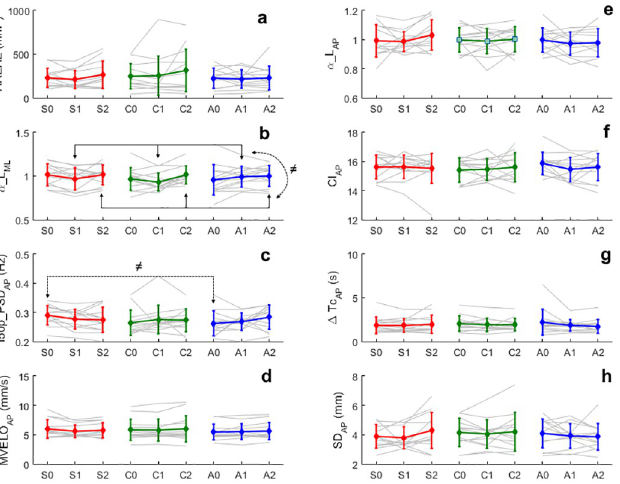
Fig 3. Graphical representation of some of the results obtained from COP parameters. Points in red correspond to the average of the parameter, from all participants, before (S0), during (S1) and after (S2) the electrical stimulation protocol in the Sham protocol. Points in green correspond to the average of the parameter, of all participants, before (C0), during (C1) and after (C2) the electrical stimulation protocol in the (CT10, AiC) protocol. Points in blue indicate the parameter average, of all participants, before (A0), during (A1) and after (A2) the electrical stimulation protocol in the (AT10, CiC) protocol. Vertical lines represent the standard deviation of the sample space. Light gray lines represent the parameter values calculated for each subject. f 50 p _ PSD AP (panel “c”) has statistically significant difference before (t0) the electrical stimulation between the Sham and (A-T10,CiC) protocols. α L (panel “b”) has statistically ML significant difference between during (t1) and after (t2) the electrical stimulation stage. The “ 6¼ ” symbol indicates the situations where statistically significant differences were observed.